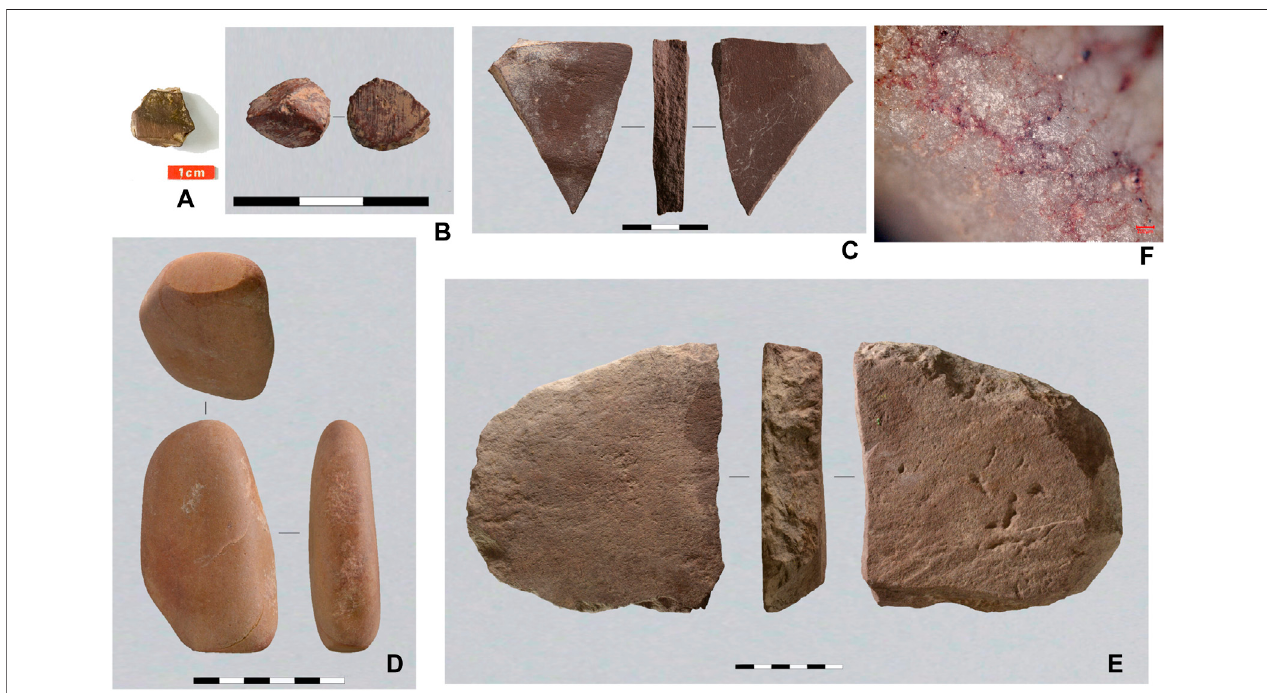
FIGURE 9 | (A) . Ochre (S9:370) from SZT9 Layer 4; (B) . Ochre (S29:60 – 103) from SZT29 Layer 7 Spits 2 – 1; (C, E) . Grinding slabs (S29:66 – 109 and S29:13110) from SZT29 Layer 7 Spits 2 – 1 with traces of ochre; (D) . Handstone (S29:11,959) from SZT29 Layer 7 Spits 2 – 1; (F) . Ochre pigment on the inner surface of a bead from SZT29 Layer